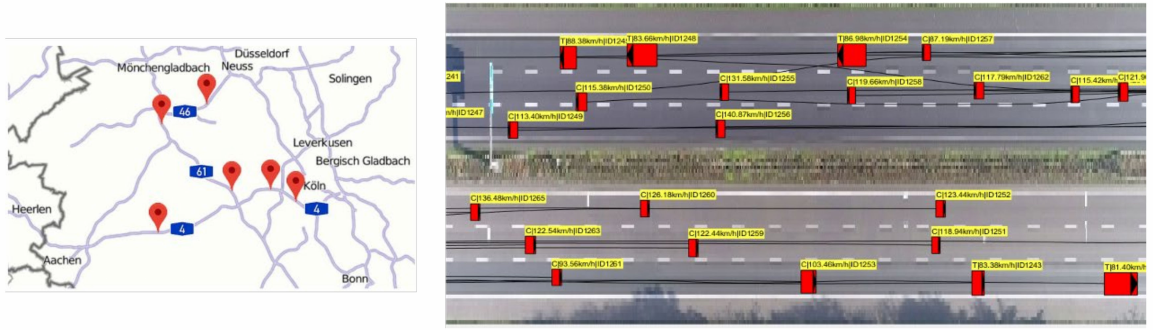
Figure 6. HighD dataset: highway traffic dataset with drone